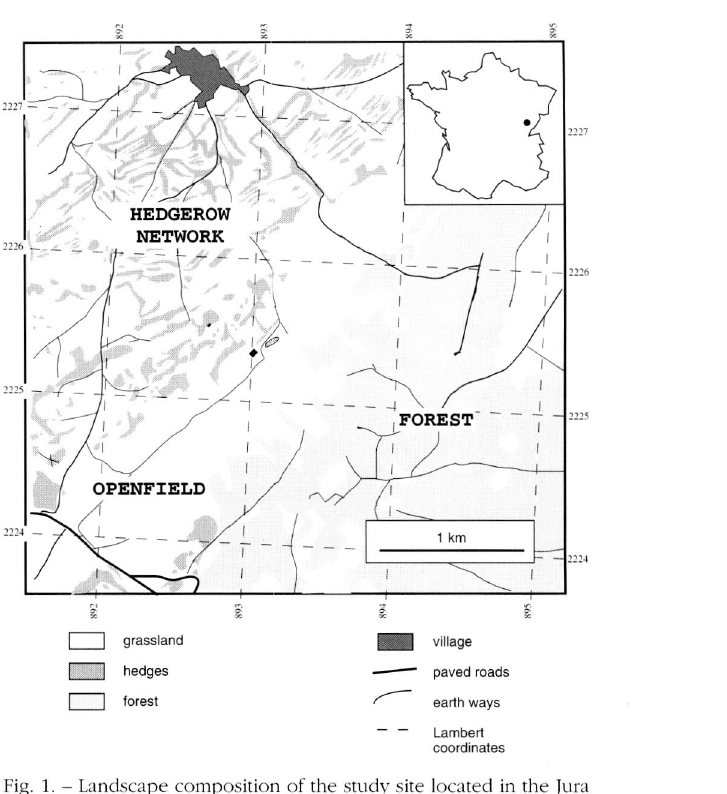
composed of forest and agricultural land. The forest is mostly semi-natural, composed of mixed beech Fagus sylvatica, oak Quercus robur, and fir Abies alba, and there are some spruce Picea abies plantations. The agricultural land is either improved grassland or per­ manent pasture (Delattre et al, 1988; Giraudoux et al., 1997), and is either, open over wide areas (open field), or enclosed by hedgerows in plots of ca 1 ha (Fig. 1).